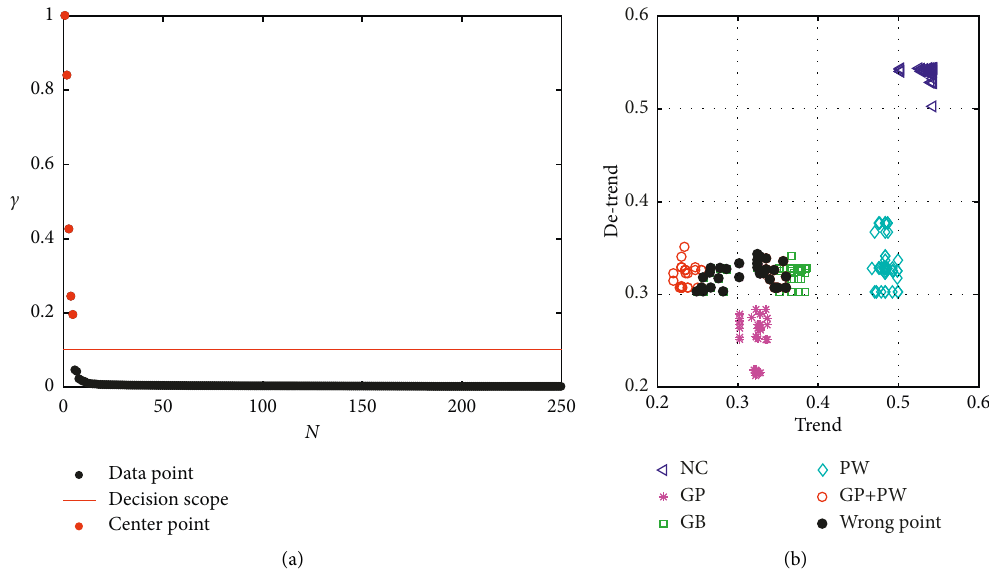
Figure 17: The clustering result of the gearbox by using the EEMD-DE-DPC: (a) decision graph and (b) clustering result. Table 7: The evaluation indexes of the gearbox under different fault diagnosis methods. Fault diagnosis methods Accuracy (%) Silhouette